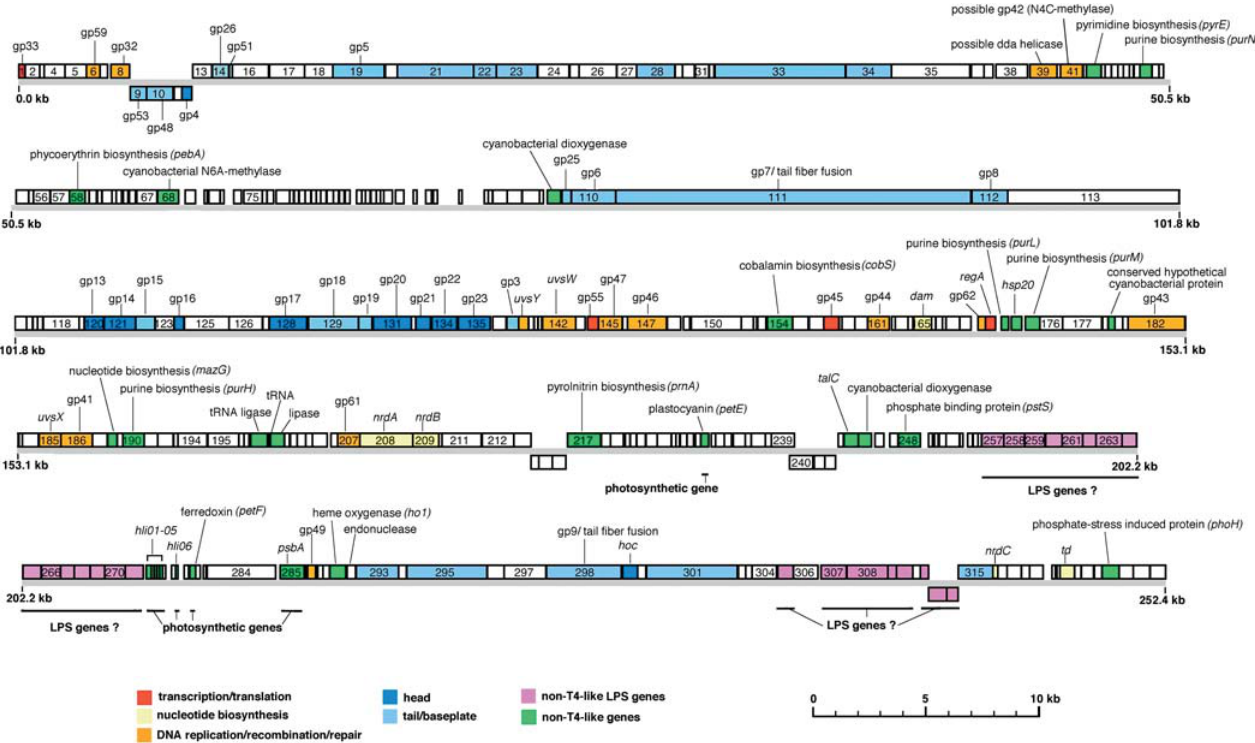
Figure 3. Genome Arrangement of the Prochlorococcus Myovirus P-SSM2 Gene names are designated above the box representing the ORF where genes were identified; descriptions of genes are in Table 4. The ORFs located above the centering line are on the forward DNA strand, whereas those below the line are on the reverse strand. Although the genome is one molecule, the representation is broken to fit the page. Colors indicate the putative role for the identified genes as inferred from T4 phage. Gene designations use T4 nomenclature for T4-like genes [104] or microbial nomenclature for non-phage genes. DOI: